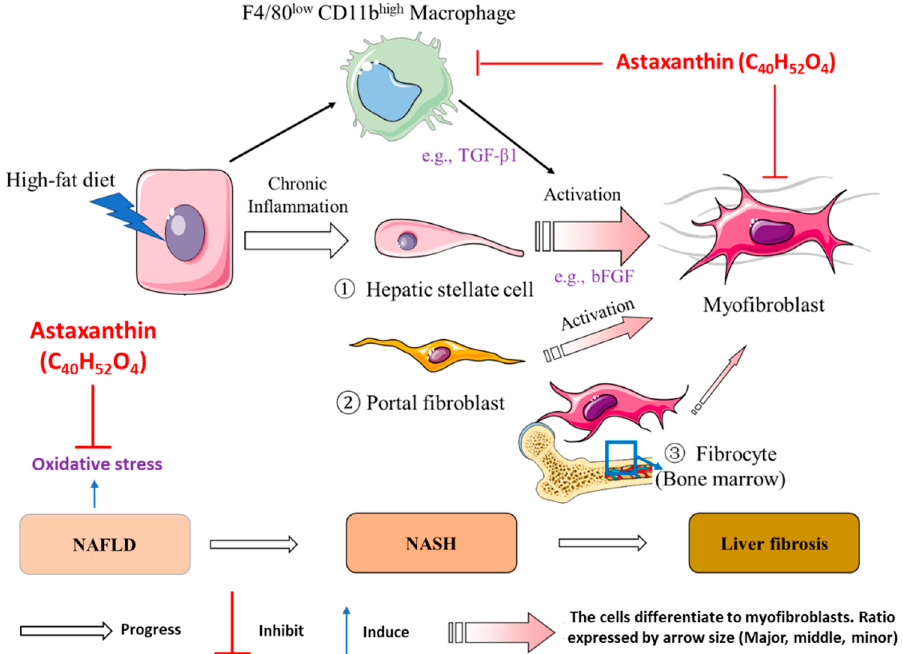
Figure 8. A schematic figure shows the effect of ASTN on NASH at the cellular and molecular levels. ASTN inhibits the infiltration of F4/80 low CD11b high macrophages, the expression of bFGF, and oxidative stress, resulting in retardation of liver fibrosis and NASH progression.